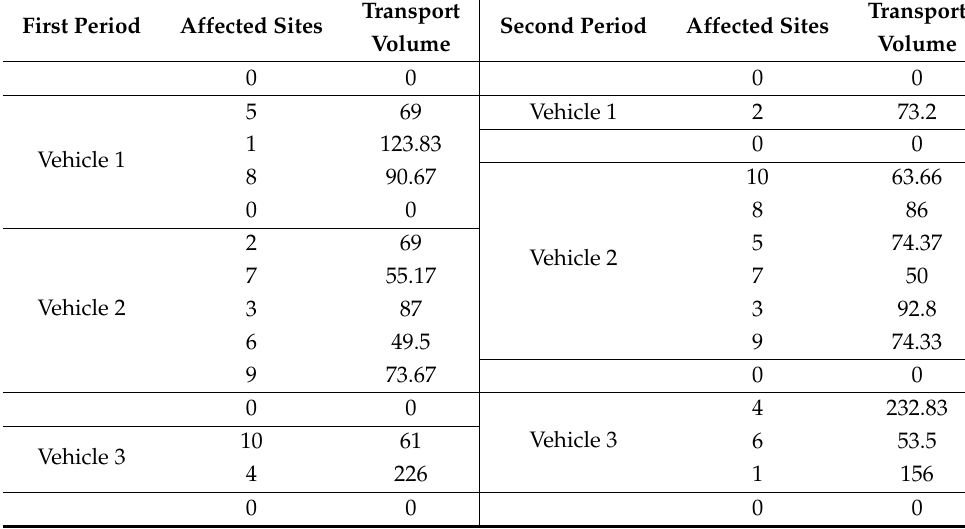
Table 9. Relationship between transport volumes at affected sites and optimal path.